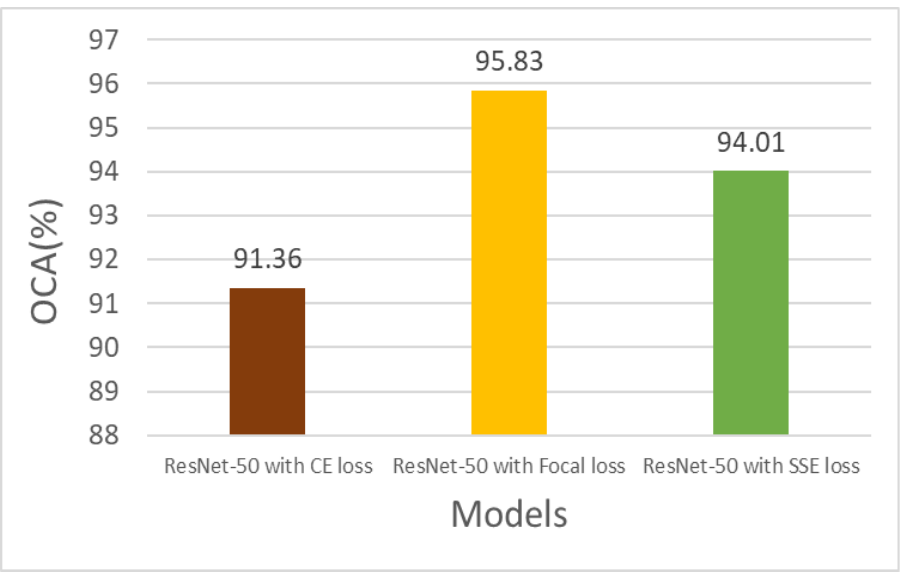
Figure 6. The effect of different loss functions of the DDSM test on overall classification accuracy.